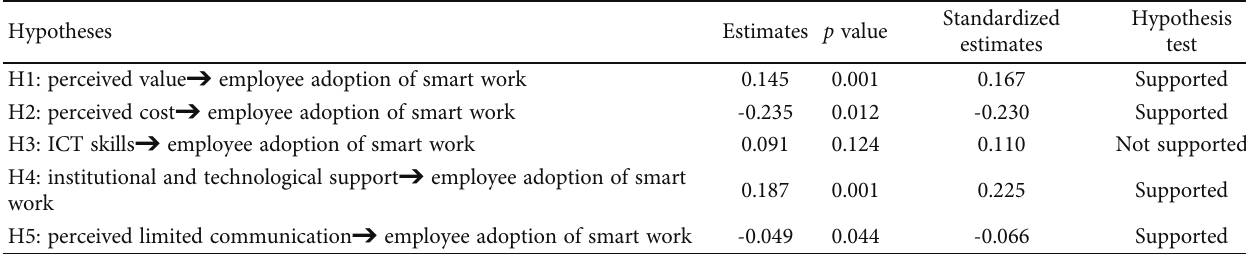
Table 6: The results of structural equation modeling estimation.